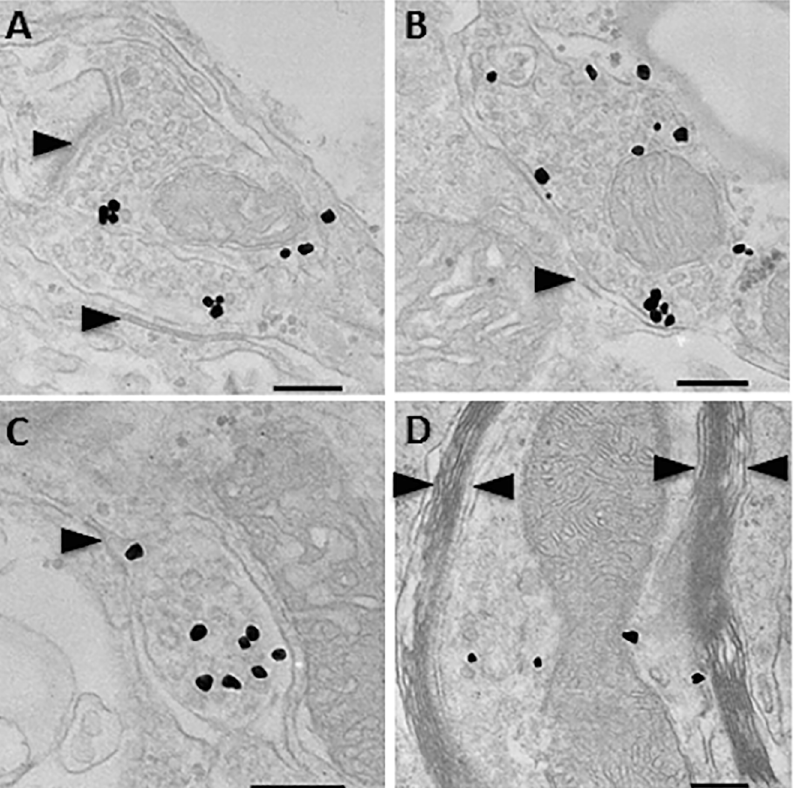
Fig 6. (A,B,C) Representative images of immune-transmission electron microscopy. Synapseformation (arrowheads) can be seen betweenhost neuronsand transplant-derived GFP+ (black labelled)neuronsat 16 weeks post-injury. (D) Grafted GFP + neuronal fibers were found in the injured spinalcord near the transplant site where they were myelinatedby thick host myelin sheatheswith more than 10 lamellae(between arrowheads). Scale bars = 200 nm